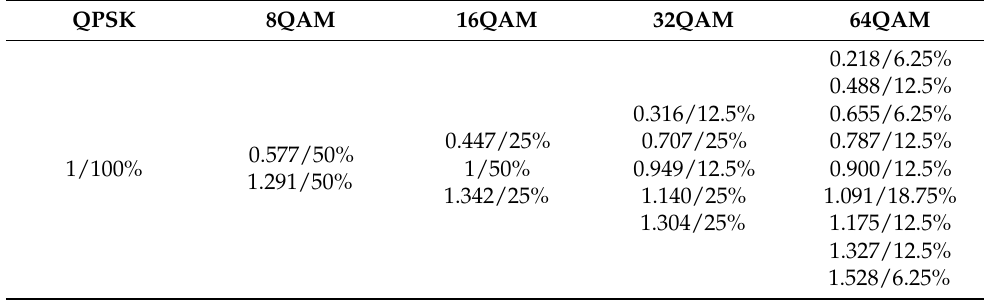
Figure 2. Constellation diagrams of five widely-employed modulation formats: ( a ) QPSK, ( b ) 8QAM, ( c ) 16QAM, ( d ) 32QAM and ( e ) 64QAM. There are one, two, three, five and nine amplitude levels for QPSK, 8QAM, 16QAM, 32QAM and 64QAM, respectively. Table 1. Amplitude value and associated probability for each level of the five modulation formats.